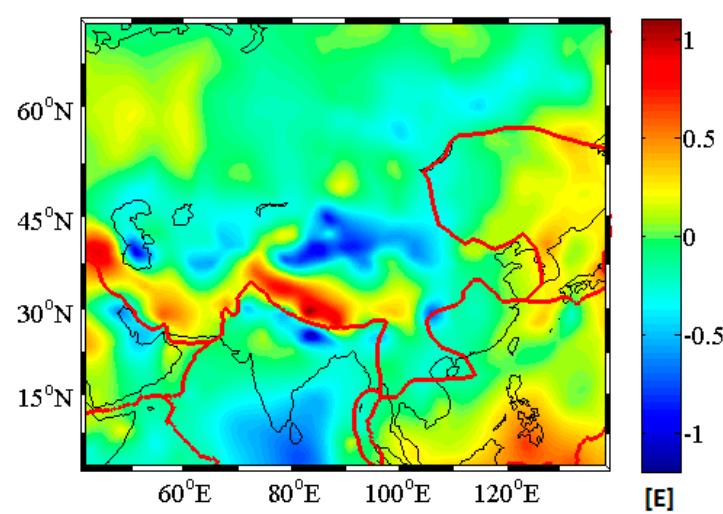
Figure 3. Gravity field and steady-state Ocean Circulation Explorer (GOCE) vertical gravity gradients.